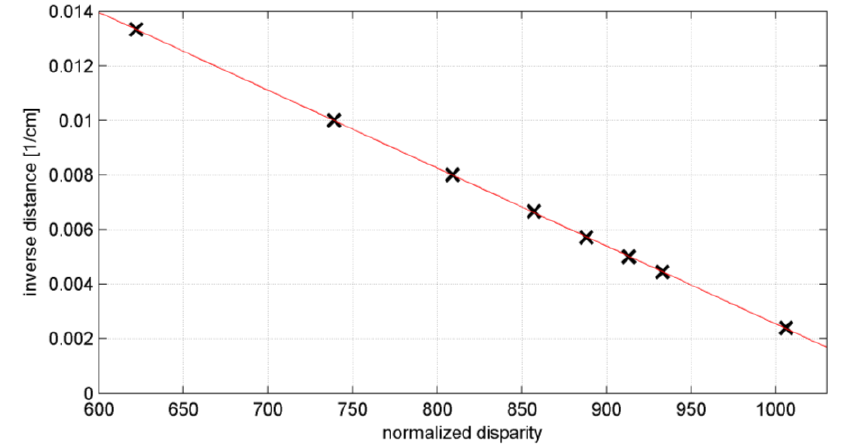
Figure 5. Linear relation of normalized disparity with inverse